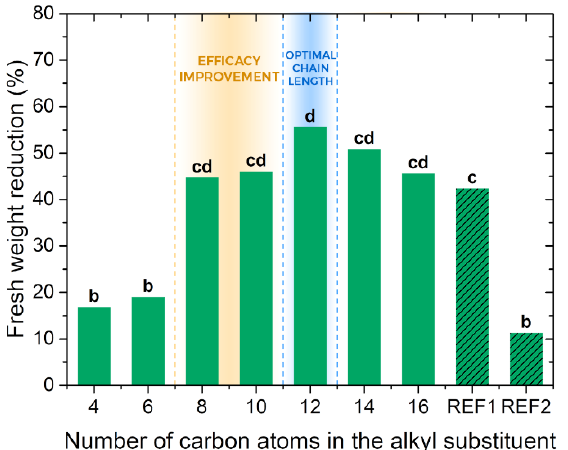
Figure 5. Biological activity of ILs 8 – 14 toward oilseed rape; REF1—potassium 2-(2,4-dichlorophenoxy)propionate, REF2—Aminopielik Standard 600 SL; different letters (b–d) indicate occurrence of statistically important differences (HSD, p < 0.05).